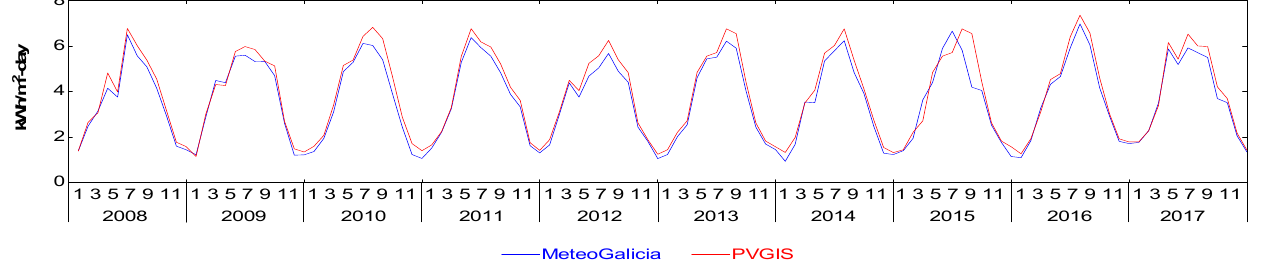
Figure 4. Evolution of the monthly mean GHR index: PVGIS vs. MeteoGalicia (Santiago EOAS, 2008–2017).